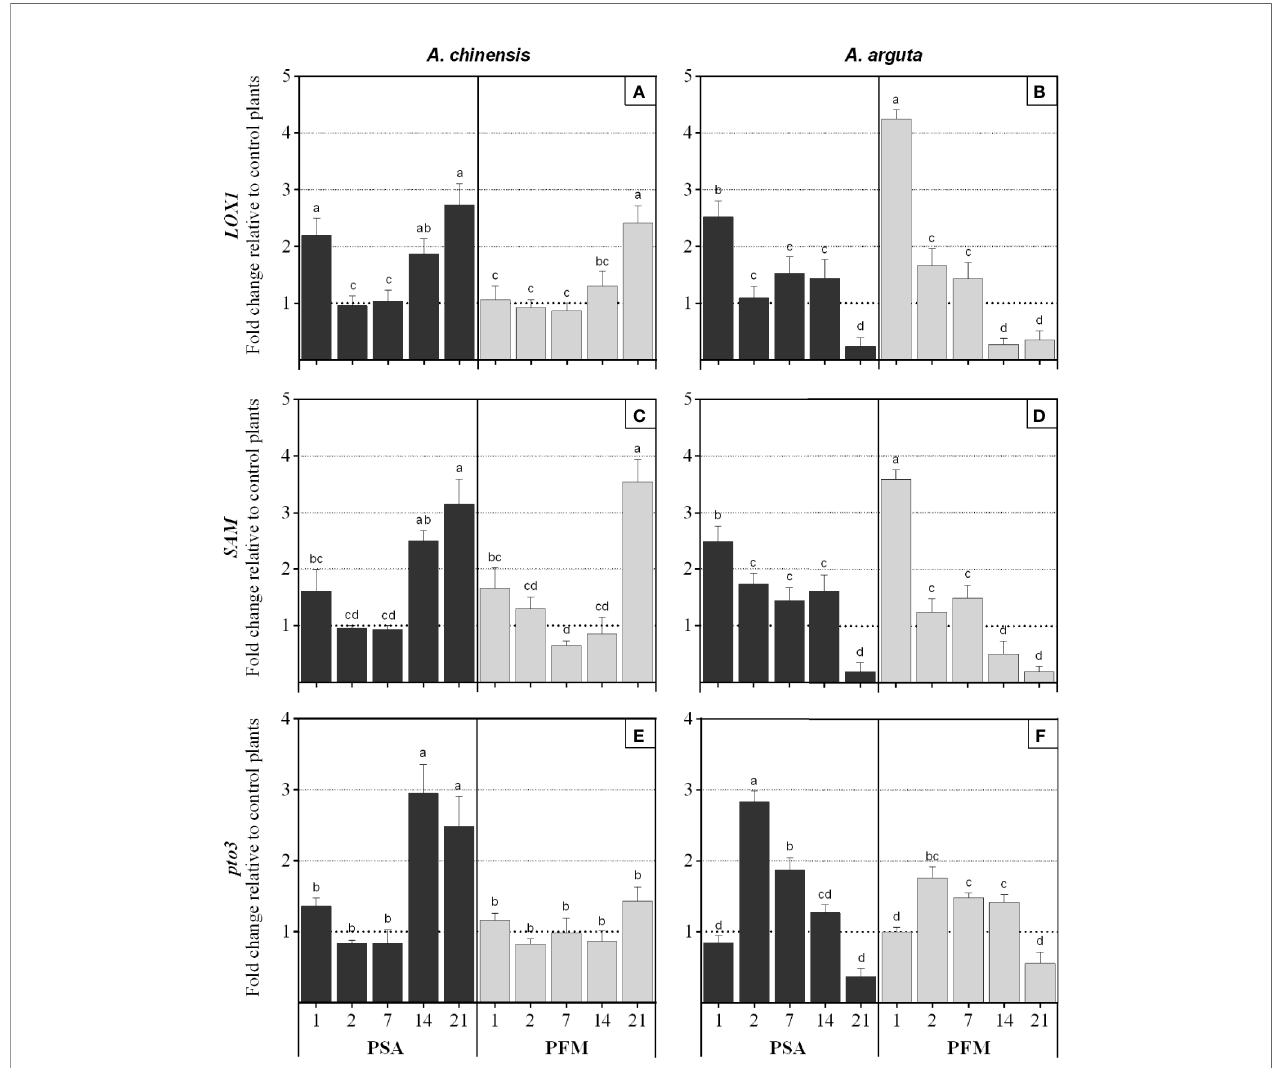
FIGURE 5 | Relative fold of expression of LOX1 (lipoxygenase 1), SAM (s-adenosylmethionine synthetase) and Pto3 (Pto-like protein kinase 3) genes in Actinidia chinensis var. deliciosa cv. ‘ Hayward' (panels A , C and E , respectively) and in A. arguta var. arguta cv. ‘ Weiki ’ plants (panels B , D and F , respectively) inoculated with Pseudomonas syringae pv. actinidiae (Psa) or P. syringae pv. actinidifoliorum (Pfm) registered 1, 2, 7, 14 and 21 days post inoculation (dpi). Columns represent the mean of three independent replicates (consisting in the pool of three plants each) ± standard error. Within the same kiwifruit species, columns with different letters are signi fi cantly different at p < 0.05. One-fold change represents no relative change in gene expression, as compared with non-inoculated control